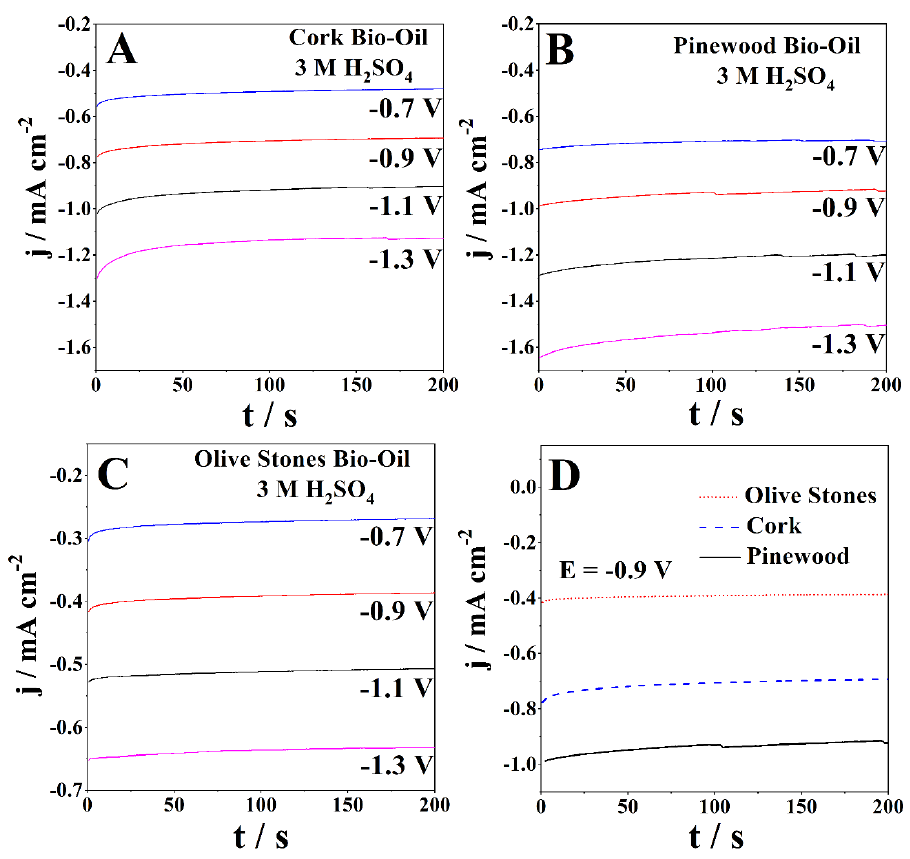
Figure 5. CAs of the samples of ( A ) cork, ( B ) pinewood, and ( C ) olive stones bio-oil, with 3 M H 2 SO 4 for applied potentials of − 0.7 V to − 1.3 V at room temperature and ( D ) direct comparison between the three different samples at − 0.9 V.